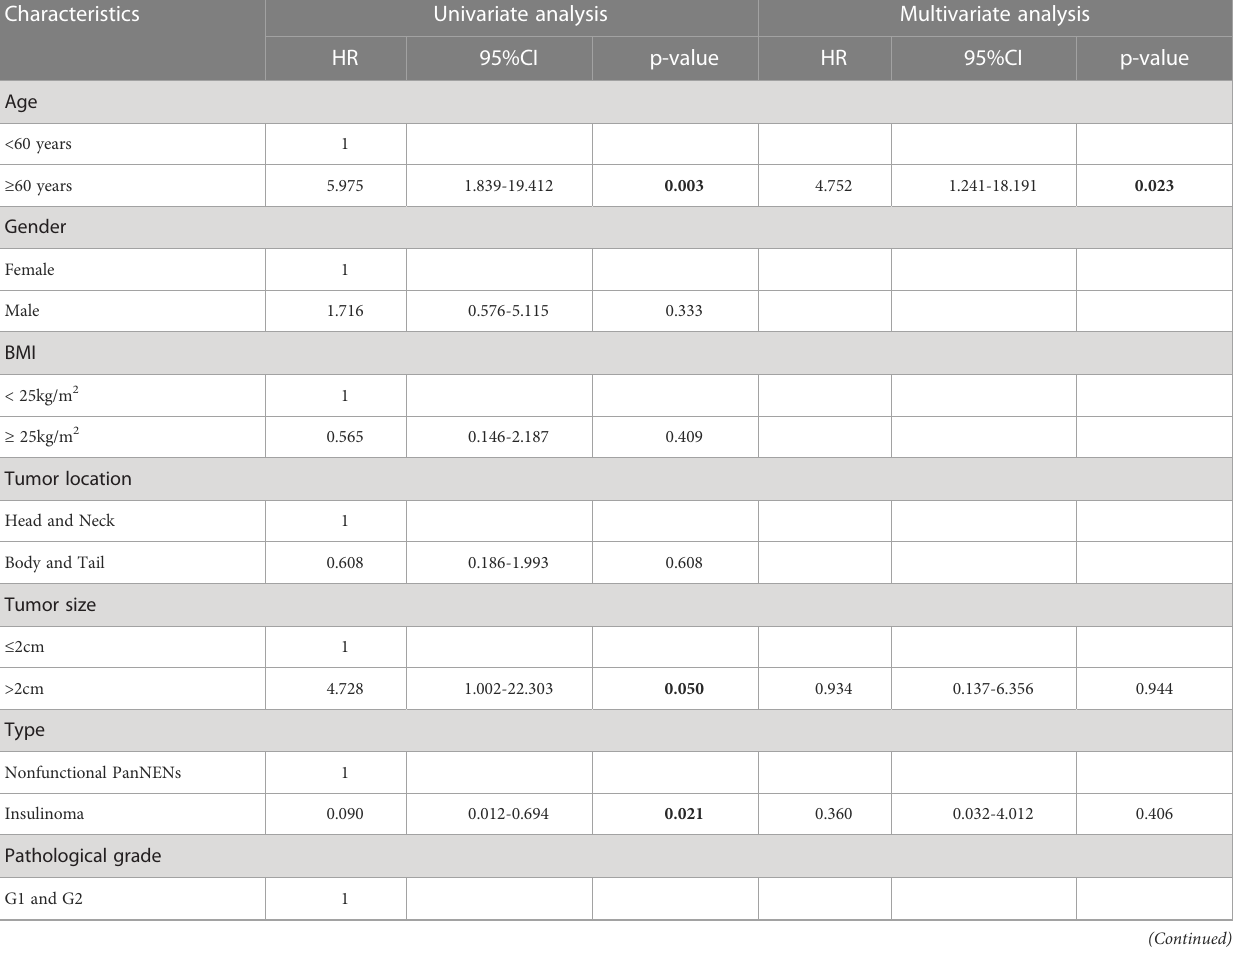
TABLE 7 Univariate and multivariate Cox proportional analysis with overall